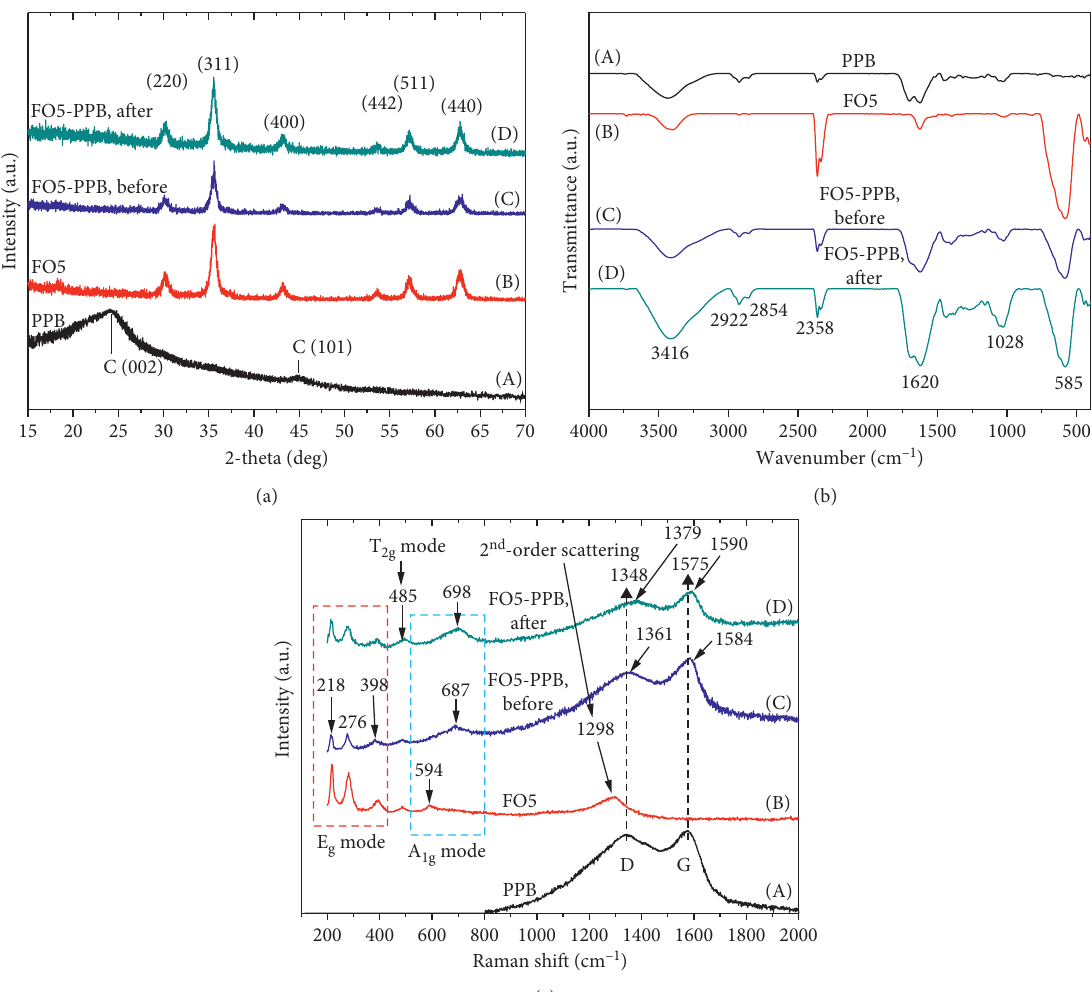
Figure 4: XRD patterns (a), FTIR spectra (b), and Raman spectra (c) of adsorbents.